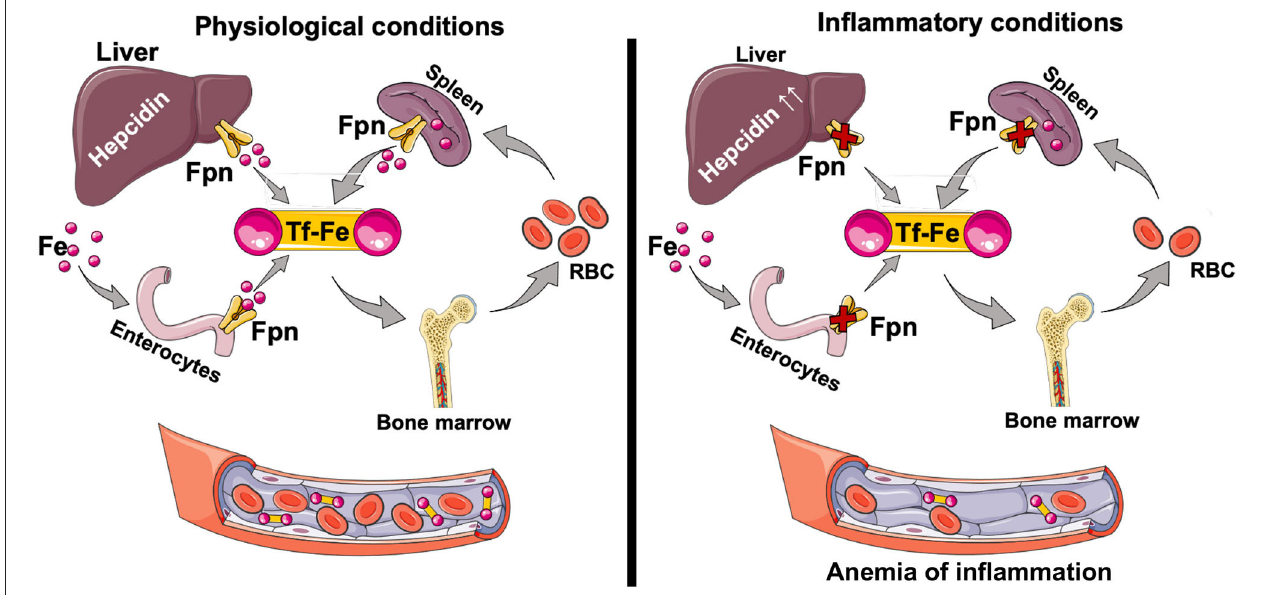
FIGURE 2 | Iron absorption and circulation. Dietary iron (Fe 2 + and Fe 3 + ) is taken up through the apical surface of the duodenal enterocytes. Within the cell, iron is used for physiological purposes, or stored complexed to ferritin. Depending on the body’s requirements, iron is transported through the basolateral surface of the enterocyte via ferroportin (Fpn) into circulation as the TfR-Fe 3 + complex. The majority of the iron is used for erythropoiesis in the bone marrow. Senescent red blood cells are cleared by the splenic red pulp macrophages, which recycle iron that then can be exported for physiological functions. Changes in circulating iron levels are sensed by the liver, which produces hepcidin, a key regulator of iron homeostasis. Hepcidin-mediated FPN degradation results in iron sequestration in macrophages and net iron absorption is decreased. The net overall effect is a decrease in circulating iron levels and decreased transferrin saturation. Hepcidin is also induced by inflammation (IL-6, IL-22, Type I interferons) resulting in anemia of inflammation. Tf, transferrin; Tf-Fe, transferrin bound iron; Fpn,